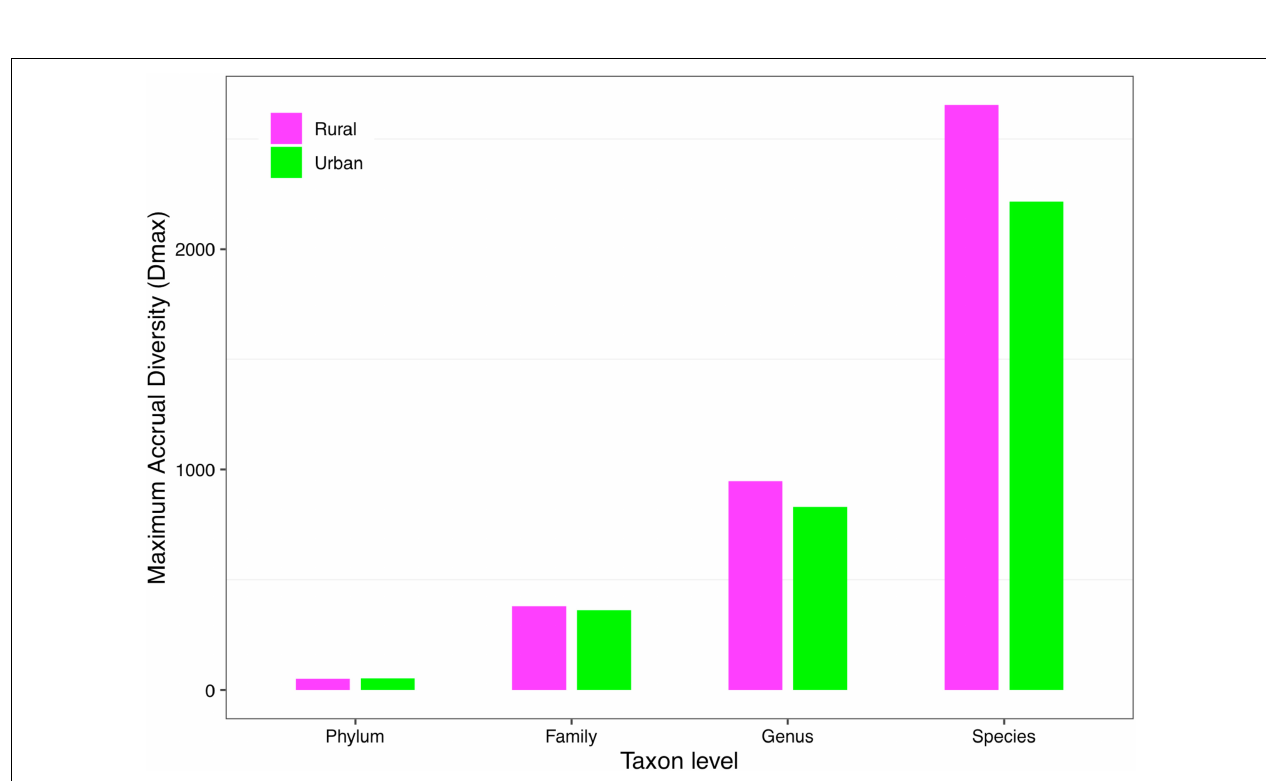
FIGURE 6 | The MAD profiles of the rural and urban cohorts at phylum, family, genus, and species levels when diversity order q = 0 (Scheme 1A).